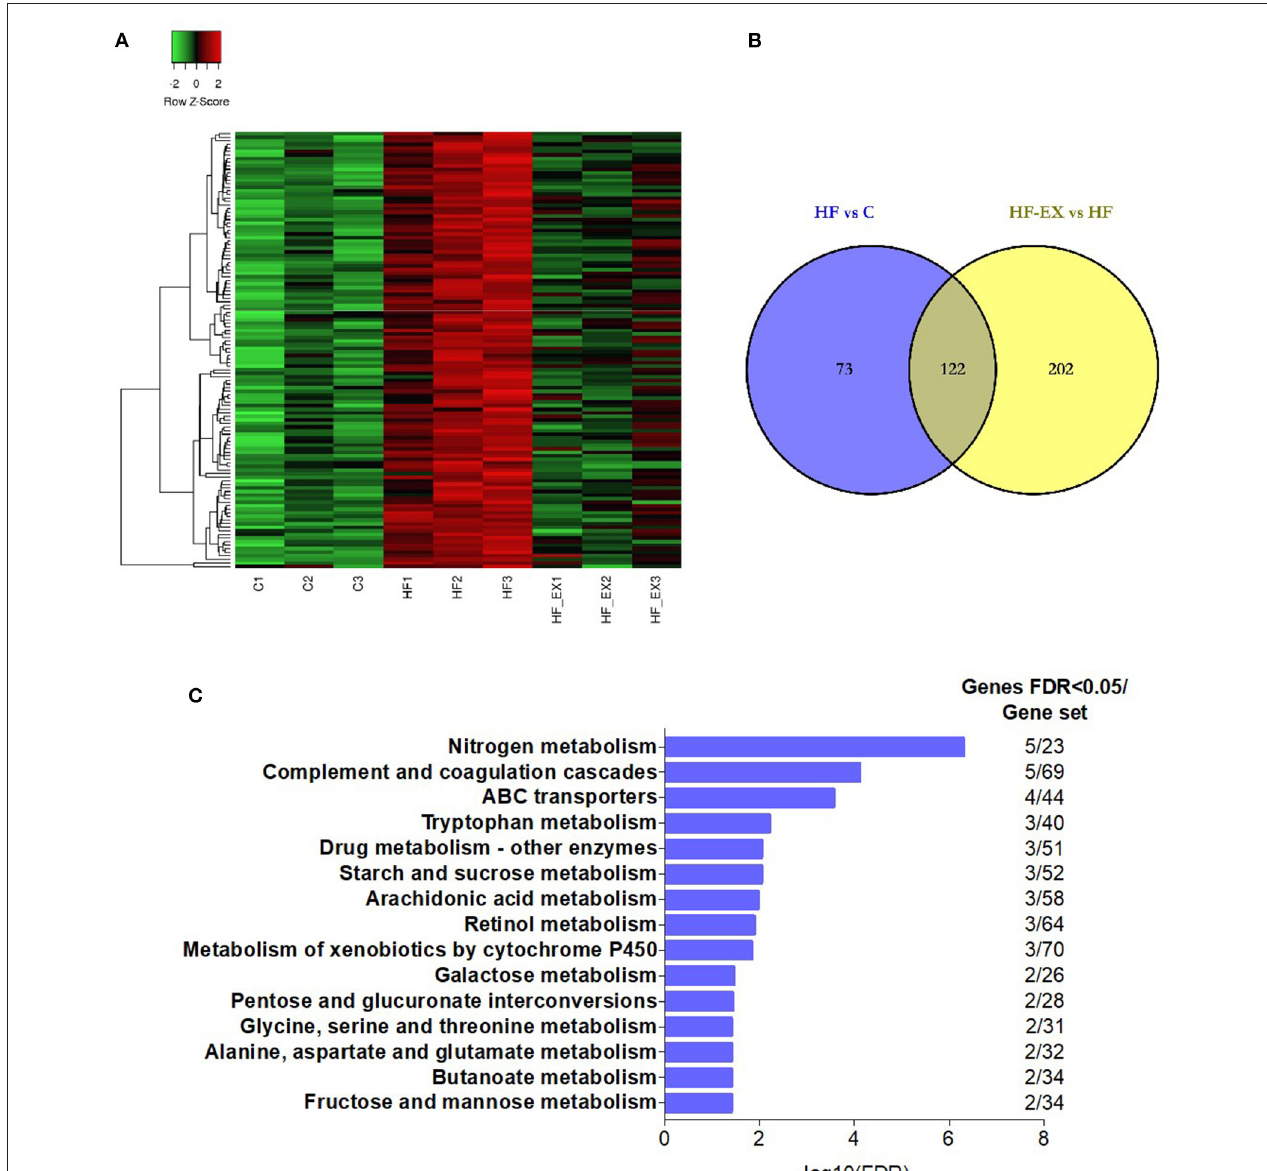
FIGURE 3 | Hepatic genes that were up-regulated by maternal HFD and down-regulated by maternal exercise and their functional analysis in adult offspring. (A) Heatmap of the differentially expressed genes; (B) Venn diagram of the differentially expressed genes; (C) Reactome pathway enrichment of the differentially expressed genes. C, offspring of dams fed the normal control diet; HF, offspring of dams fed the high-fat diet; HF-EX, offspring of dams intervened with a high-fat diet and exercise ( n = 3/group); HFD, high-fat diet. results were repeated by RT-qPCR and verified the reliability of our transcriptome sequencing results ( Supplementary Figure 1